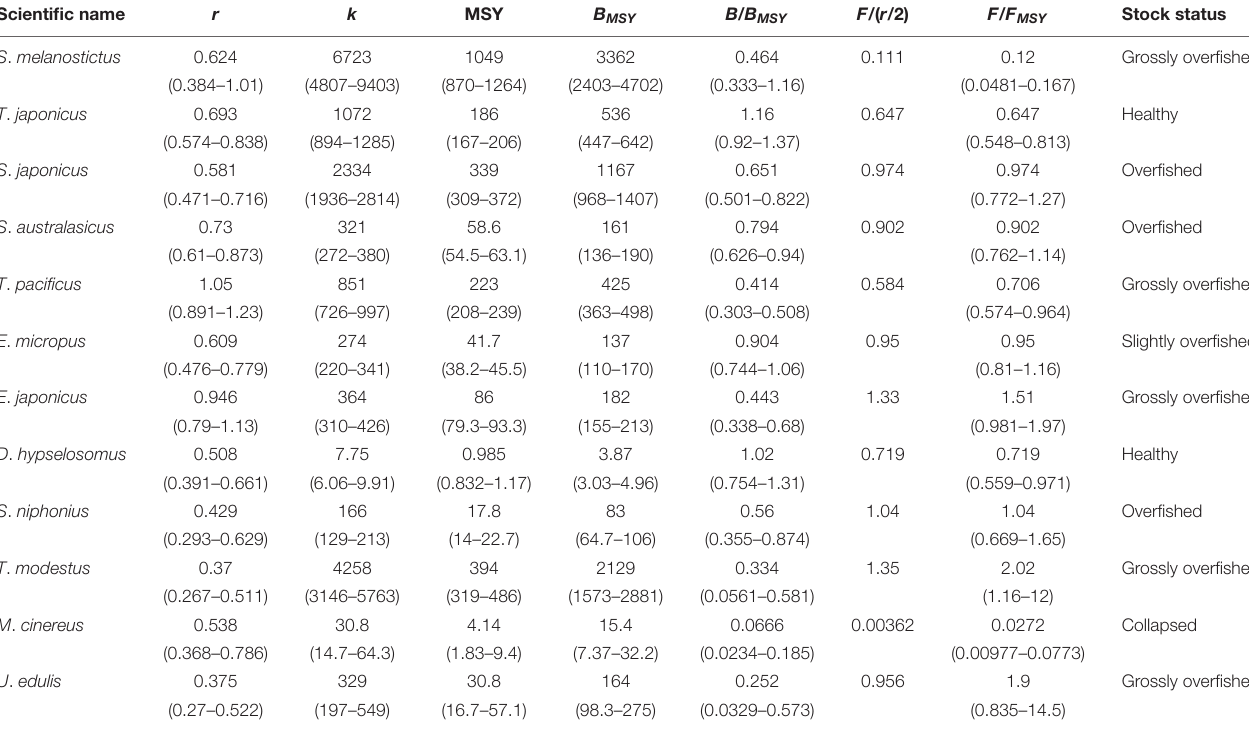
TABLE 3 | Results of the CMSY and BSM analyses with 95% confidence interval in relative brackets ( k , MSY, and B MSY in